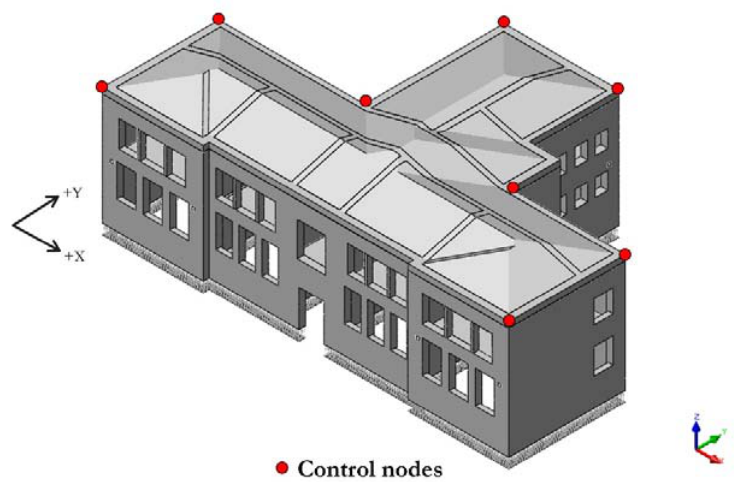
Figure 14: Directions and control nodes for the pushover